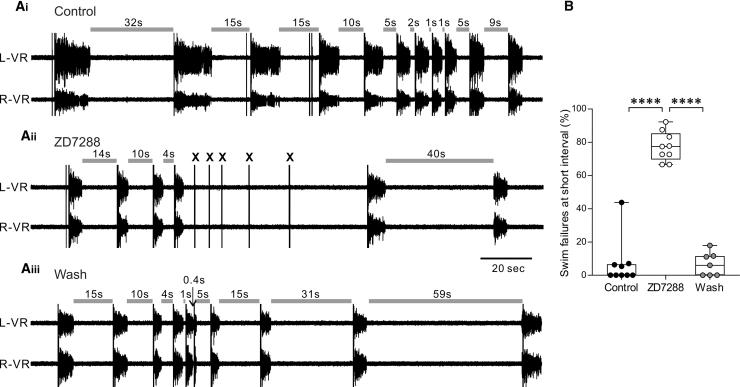
Block of Ih Current Disrupts the Relationship between Swim Interval and Episode Duration and Increases Swimming Failure at Short Intervals(A) Raw traces showing two simultaneously recorded ventral root traces on the left (L-VR) and right (R-VR) sides showing evoked swim episodes using variable inter-episode intervals. In control conditions (Ai), shortening the inter-episode interval reduces episode duration, but swimming can still be reliably evoked at very short intervals (≤2 s). In the presence of ZD7288, swimming initiation failed at short intervals (Aii; crosses, stimuli failing to evoke swimming), an effect which reversed upon drug washout (Aiii).(B) Pooled data illustrating that block of Ih significantly increases the swim failure rate at short inter-swim intervals (n = 6; median with 50% IQR displayed as box-and-whisker plot). ∗∗∗∗p < 0.0001.